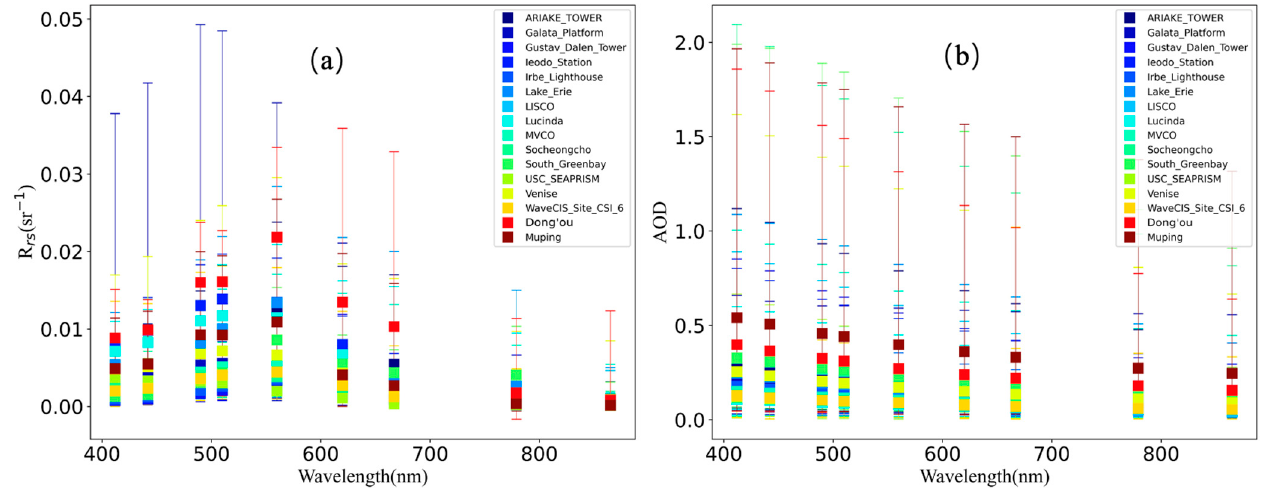
Figure 11. Comparison of mean and standard deviation of ( a ) R rs and ( b ) AOD at 14 AERONET-OC sites, as well as the Dong’ou and Muping sites.